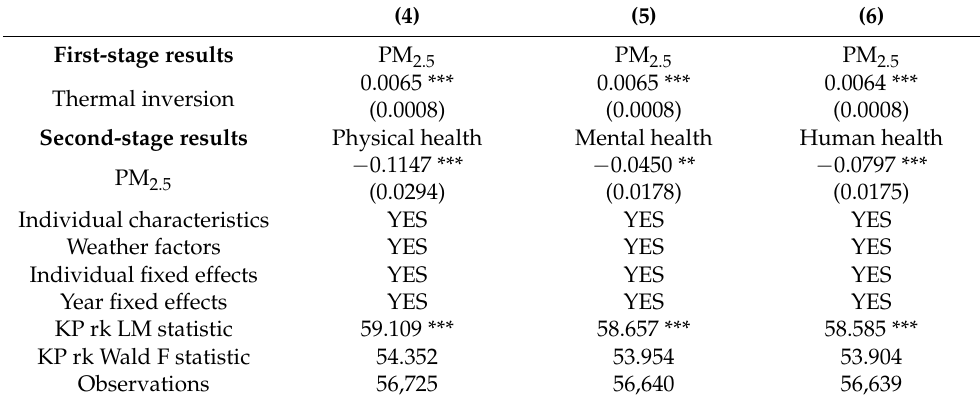
Table 3. IV estimates of the influence of air pollution on physical, mental, and human